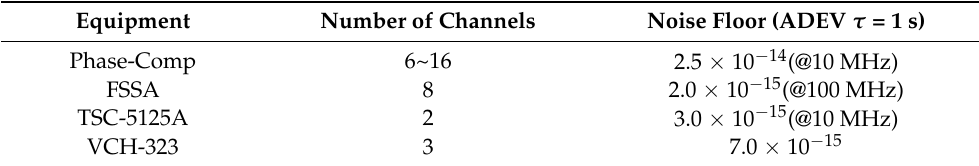
Table 1. The performance parameters of each frequency standard comparison equipment.